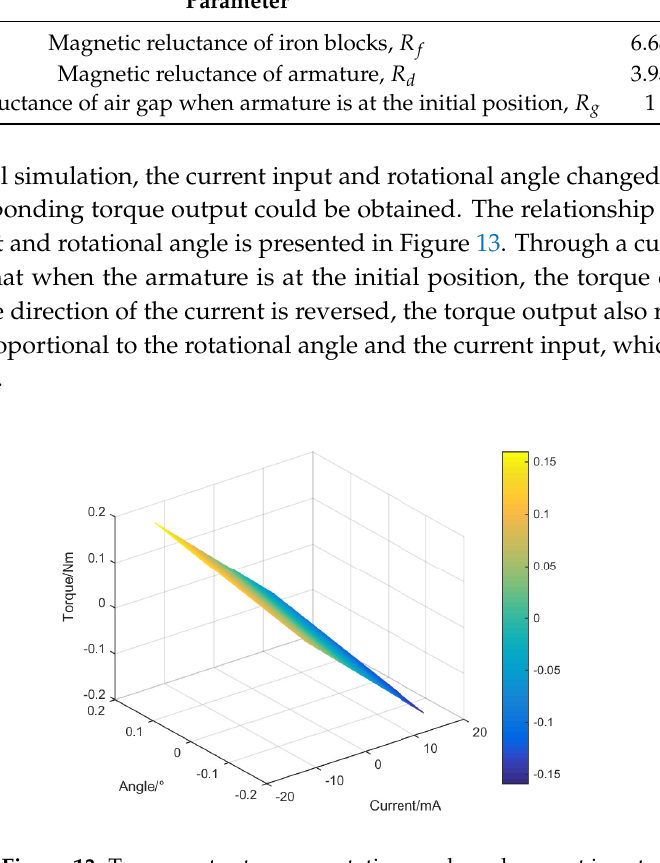
Figure 13. Torque output versus rotation angle and current